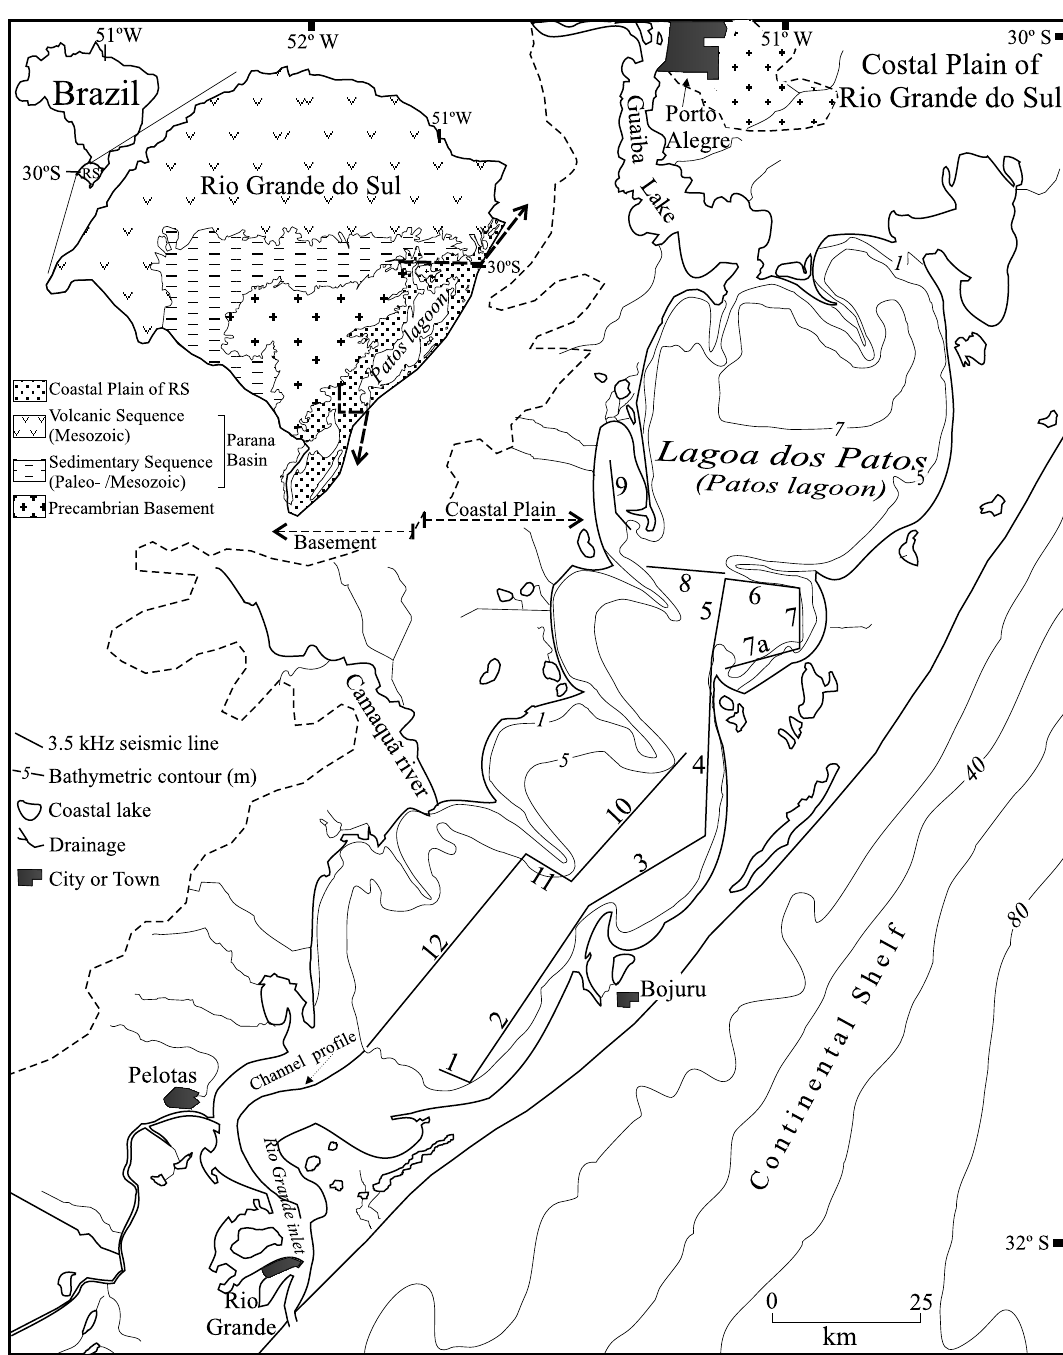
Fig. 1 – Location map of the area of study and position of the 3.5 kHz seismic lines 1–12 mapped in the Patos Lagoon.